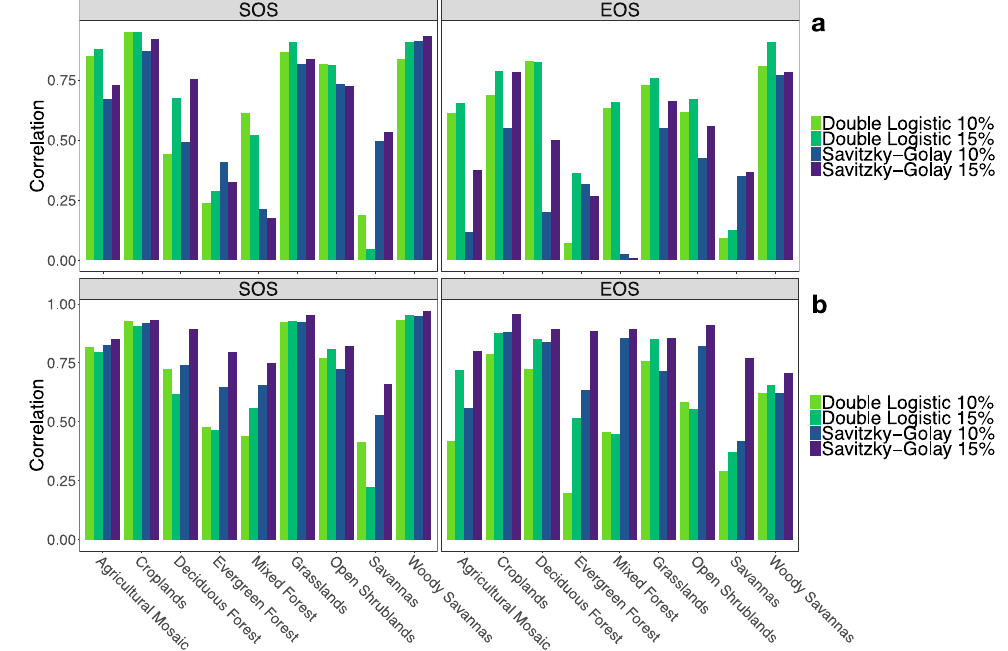
Figure 5. Correlation coefficients for comparison among the C5 ( a ) and C6 ( b ) MLCD products and different TIMESAT approaches for each land cover class included in the analysis. The left-hand side panel shows results start of season (SOS) and the right-hand side panel shows results for end of season (EOS). Different colors represent the four different approaches implemented in TIMESAT. All SOS and EOS correlation values are statistically significant at p < 0.05 with the exception of Mixed Forest for C5 EOS versus Savitzky–Golay 10% and 15% as well Evergreen Forest C5 EOS versus double logistic 10%.